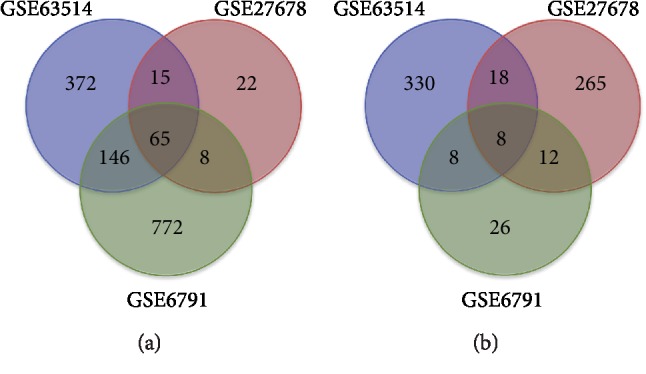
Authentication of 73 common DEGs in the three datasets (GSE63514, GSE27678, and GSE6791) via Venn diagrams software. Different color represents different datasets. (a) 65 DEGs were commonly up-regulated in the three datasets (logFC > 1.5). (b) 8 DEGs were commonly down-regulated in the three datasets (logFC<−1.5).